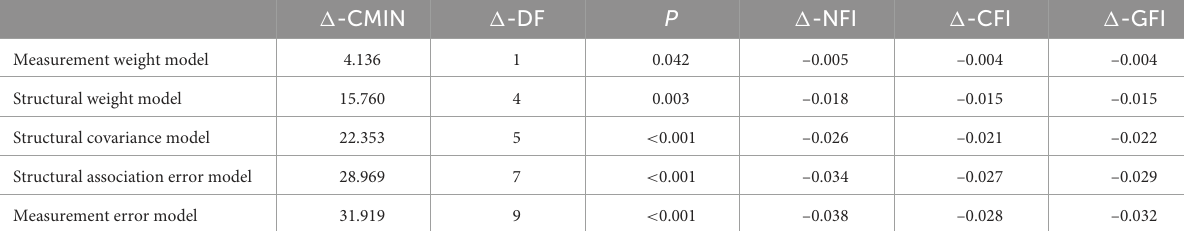
TABLE B1 Model difference